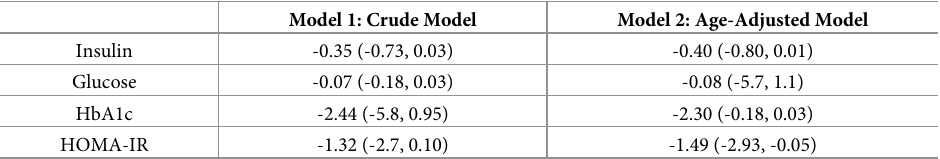
Table 4. Beta coefficients and 95% confidence intervals from linear regression models describing the relationship between insulin-glucose homeostasis and D3Cr muscle